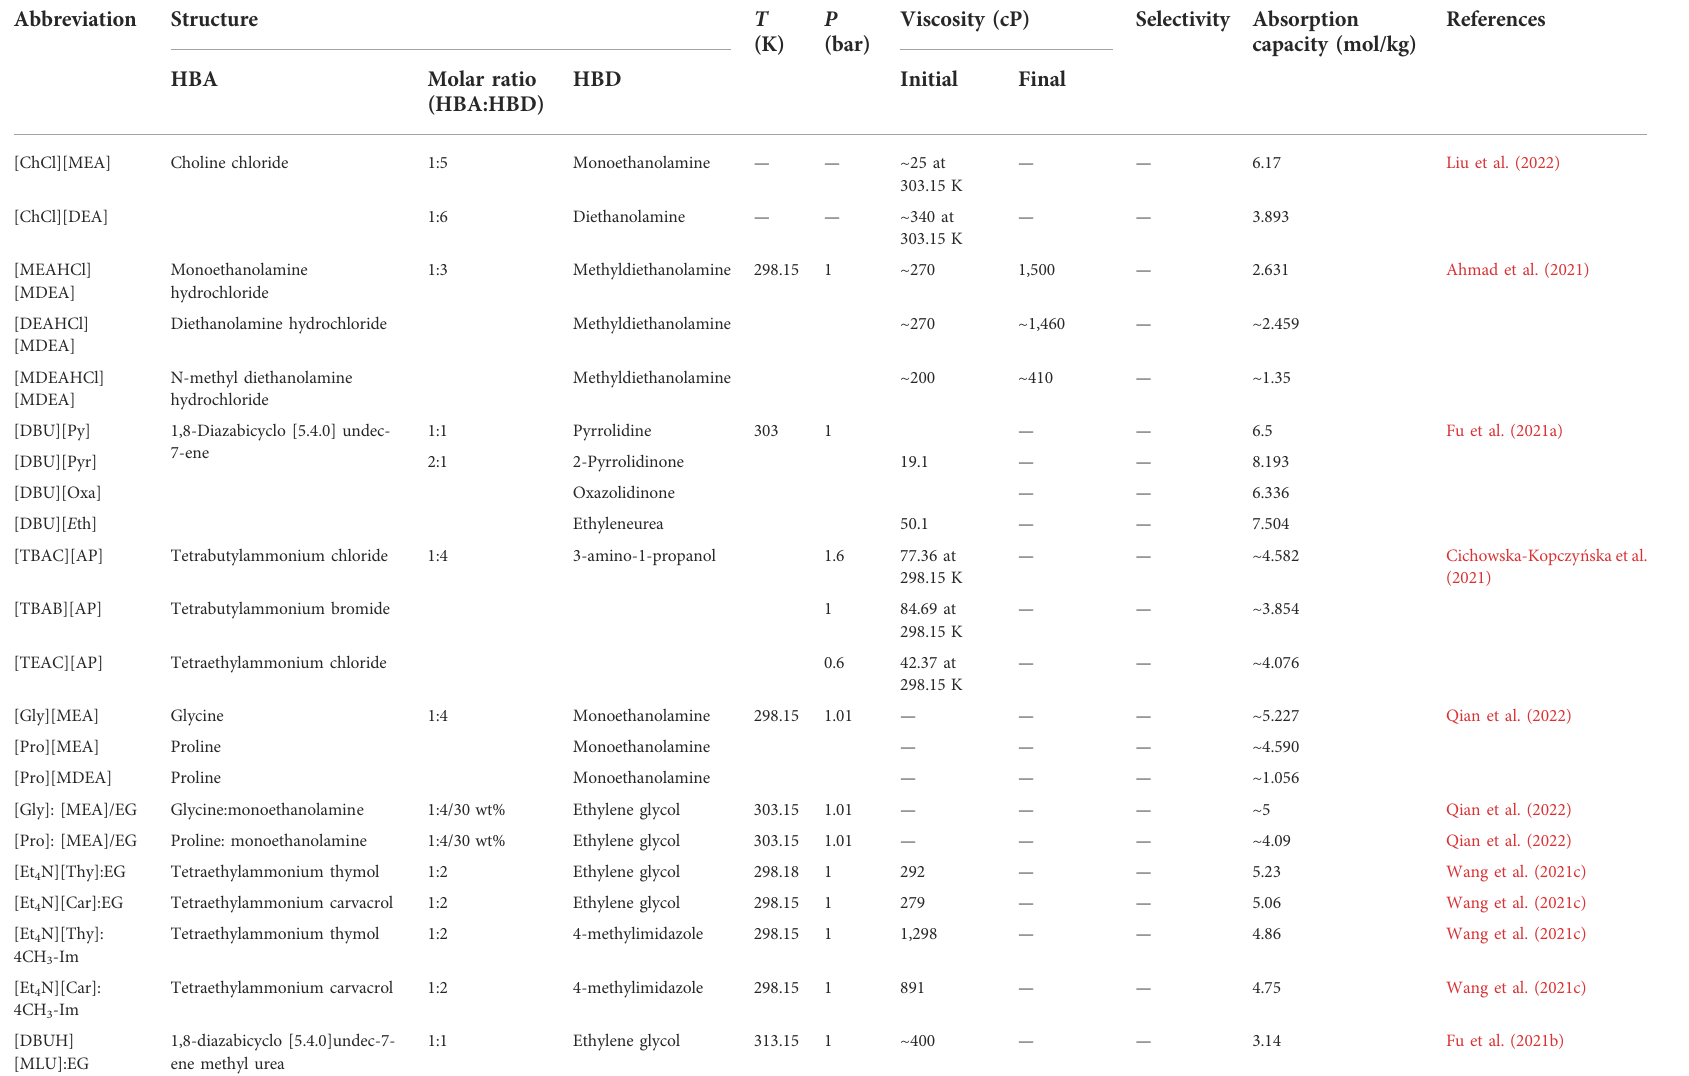
TABLE 4 Chemical-based DESs reported in 2021 –